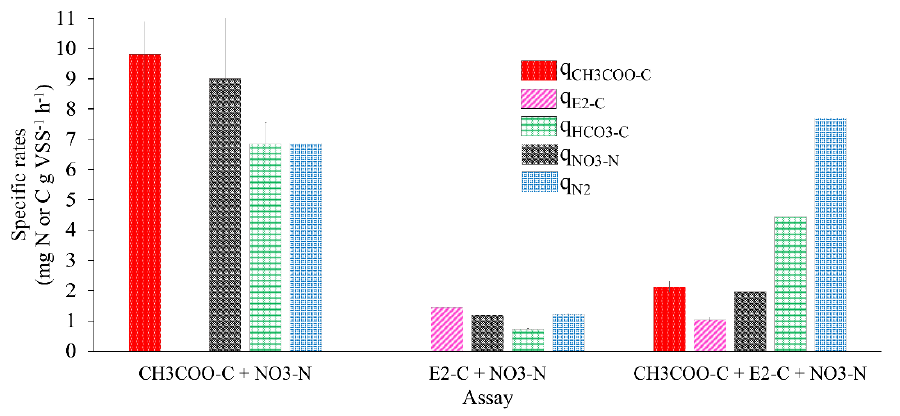
Figure 3. Specific rates (q) of substrate consumption and product generation in batch denitrifying